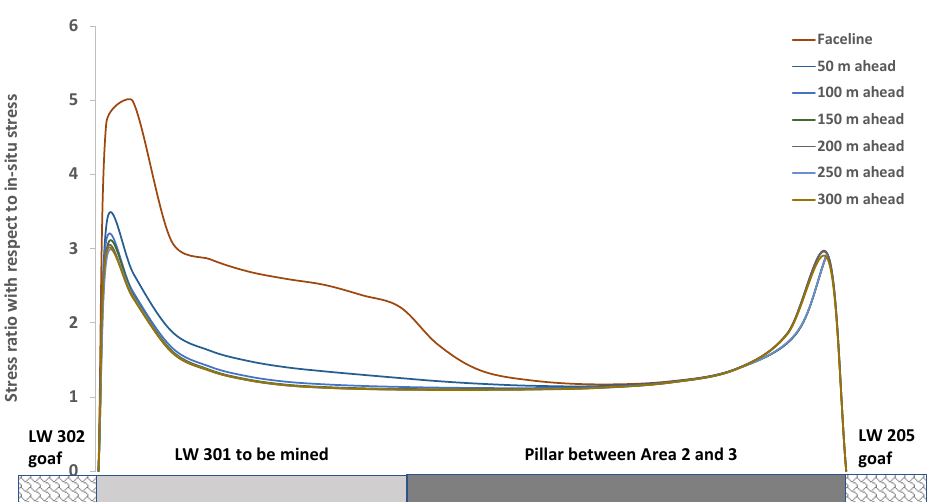
Figure 12. Vertical stress development ahead of longwall 301.